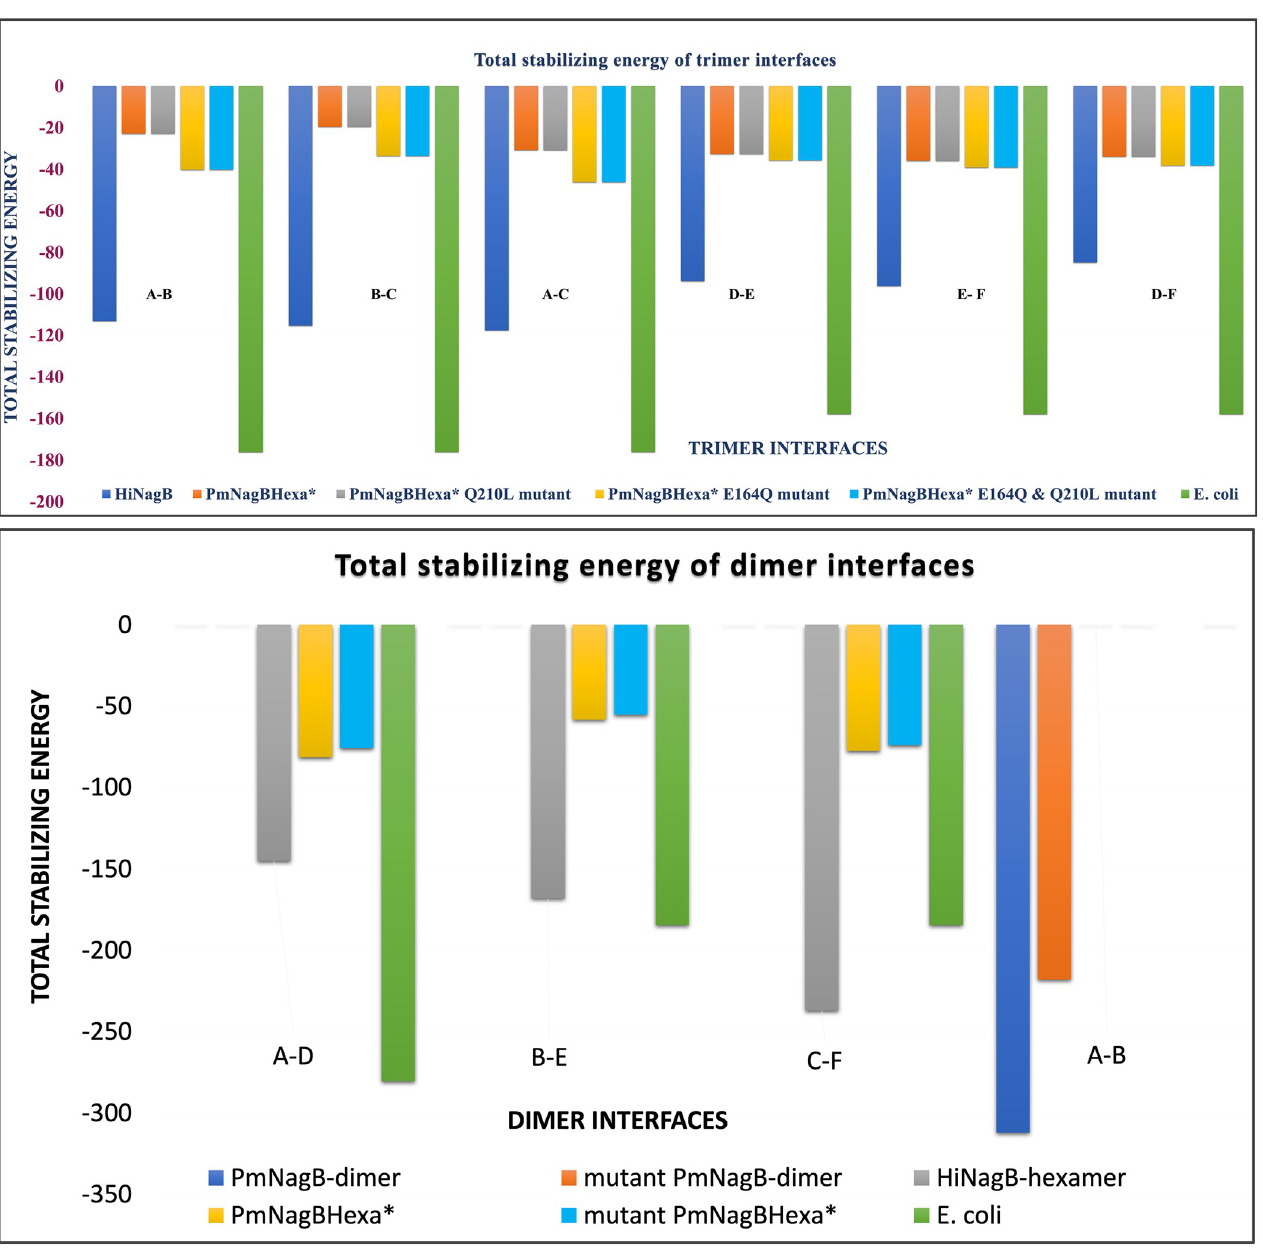
Fig 5. A: Total stabilizing energy of trimer interfaces of Hi NagB, E . coli , PmNagB Hexa � and its mutants (E164Q, Q210L and E164Q, Q210L double mutant) as calculated by PPCheck B: Total stabilizing energy of dimer interfaces of Hi NagB, E . coli , Pm NagBHexa � and its mutants (Y206H, P242A, T244Q triple mutant) as calculated by